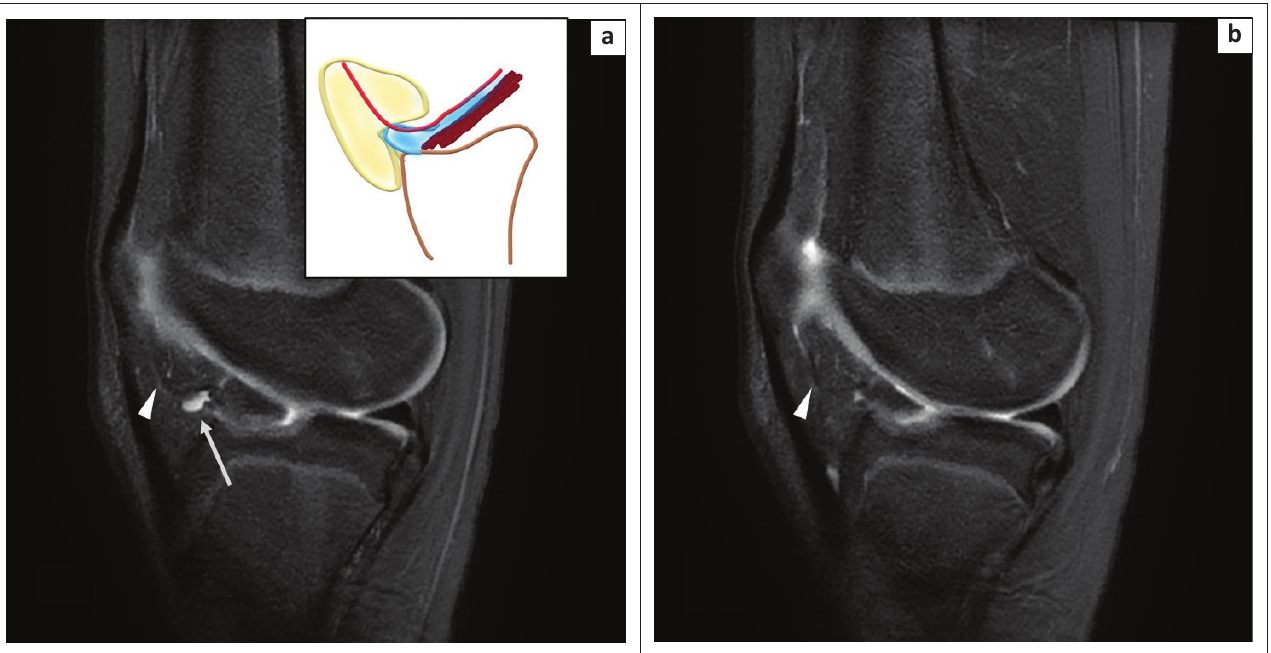
FIG URE 11: Magnetic resonance imaging of a normal horizontal cleft in Hoffa’s fat pad in a 14-year-old girl with a history of a fall: oblique sagittal PDFS image (a) shows the fluid-filled cleft (arrow) inferior to the infrapatellar plica (arrow head) in the posterior part of Hoffa’s fat pad, communicating with the joint cavity. The schematic representation of the horizontal cleft is shown in blue in the inset in (a). Oblique sagittal PDFS image (b) shows the separate intact infrapatellar plica (arrow head). Note the anterior cruciate ligament avulsion fracture which was the cause of pain in this